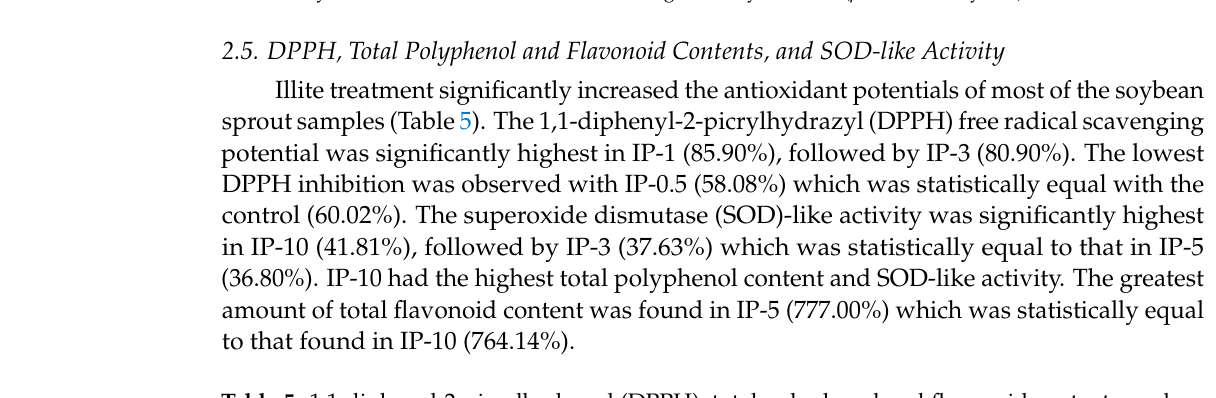
Table 5. 1,1-diphenyl-2-picrylhydrazyl (DPPH), total polyphenol and flavonoid contents, and su- peroxide dismutase (SOD)-like activity of soybean sprouts treated with different concentrations of